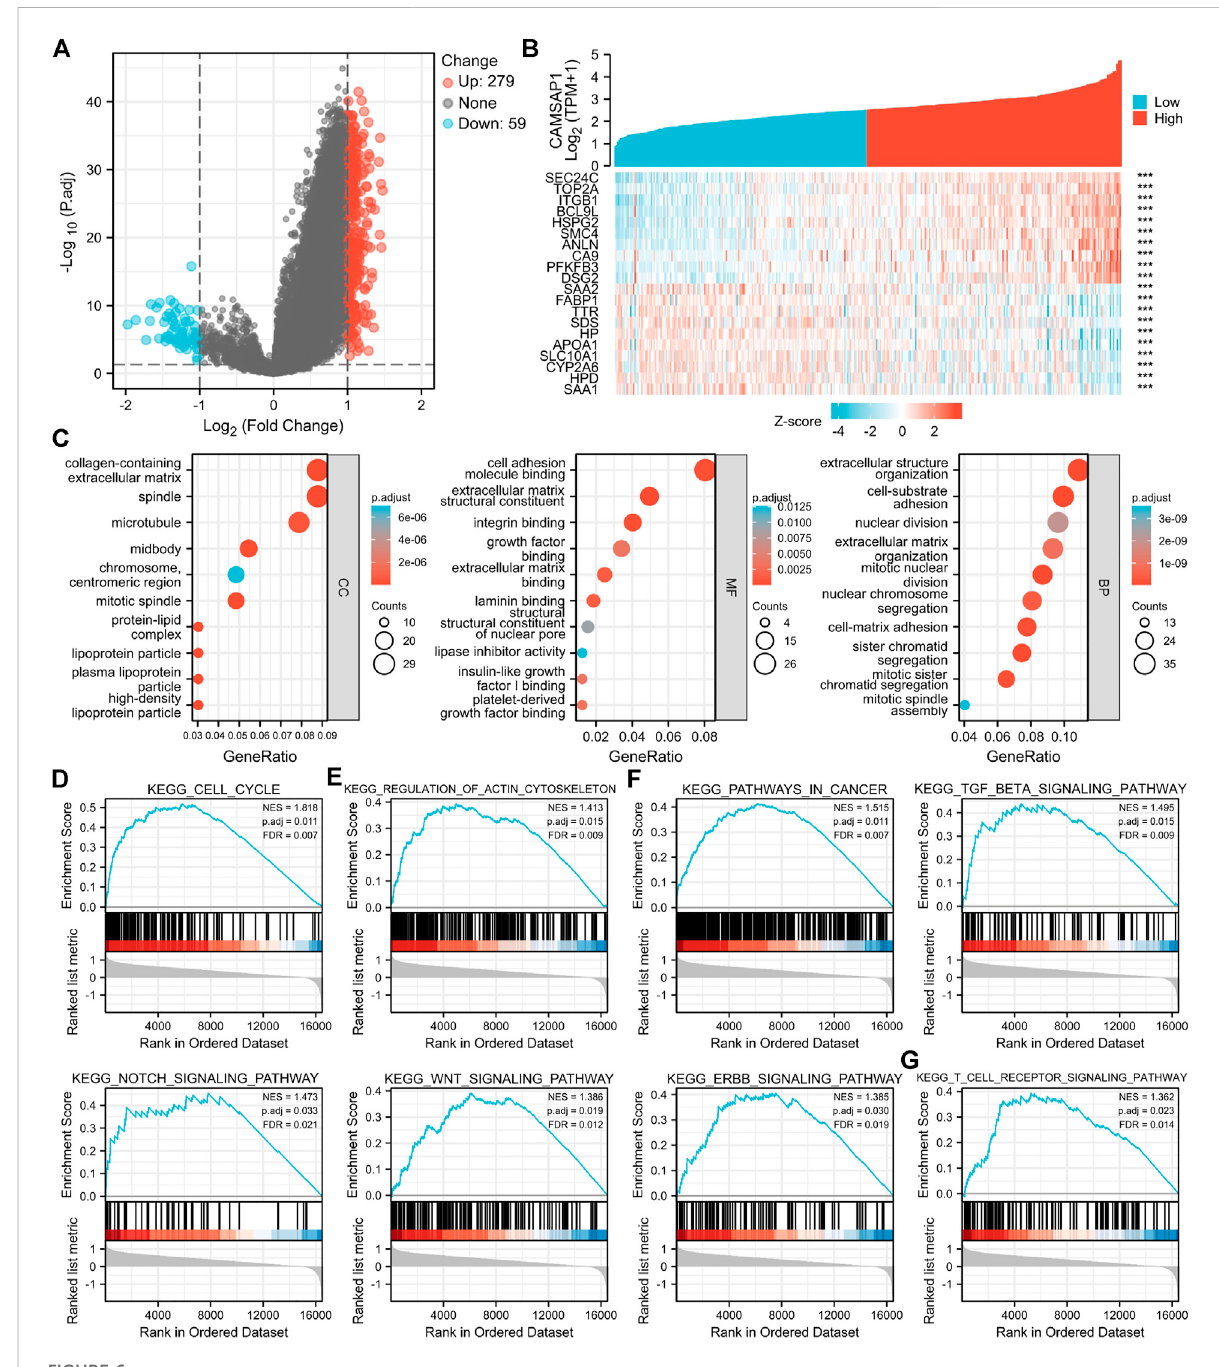
FIGURE 6 CAMSAP1 -related DEGs are enriched in immune-associated pathways. (A) A volcano plot of CAMSAP1 -related DEGs. (B) A heatmap of correlation between CAMSAP1 and the top 20 DEGs. *** p < 0.001. (C) Bubble plots from GO enrichment. (D – G) Enrichment plots from GSEA. p < 0.05 and FDR < 0.05 were considered the meaningful